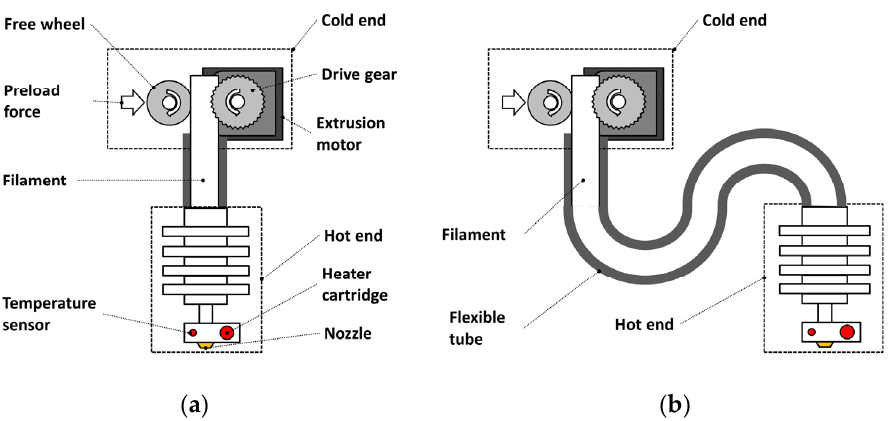
Figure 1. Extruder system layouts: ( a ) Wade extruder (direct) and ( b ) Bowden extruder. Dimensions not to scale.